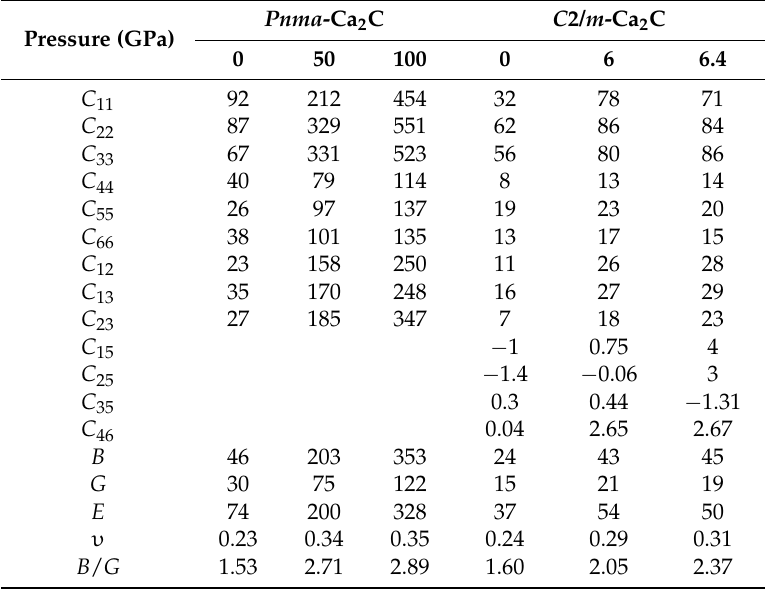
Table 3. Calculated elastic constants C ij (GPa), bulk modulus B (GPa), shear modulus G (GPa), Young’s modulus E (GPa), Poisson’s ratio υ , and B / G ratio of Ca 2 C at various